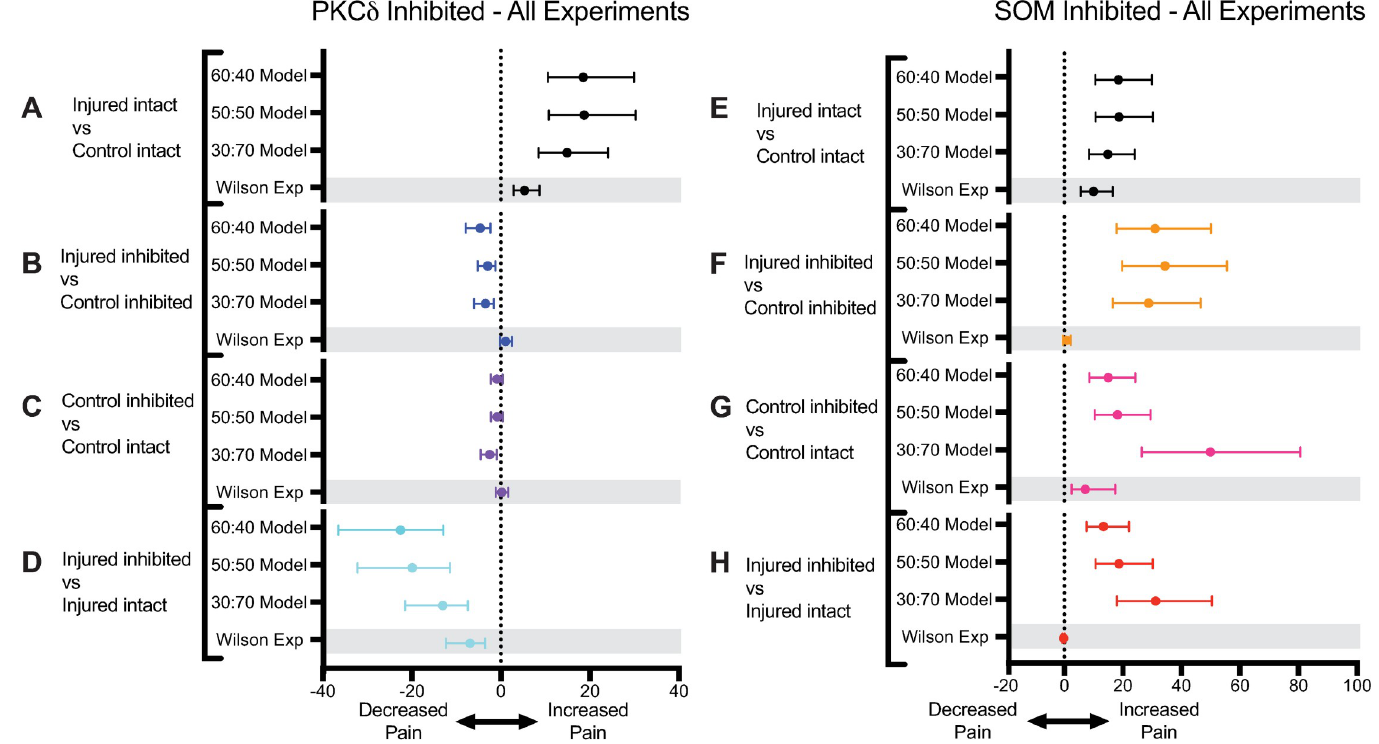
Fig 10. Standardized mean effect differences between wet-lab experiment and model simulations. Hedges’ g standardized mean effect differences were calculated between different groups from our wet-lab experiments and three models (60:40, 50:50, and 30:70) which differed based on the PKC δ :SOM ratio. Forest plots show Hedges’ g +/- 95% confidence intervals. Positive Hedges’ g is indicative of an increase in pain-like effect for the indicated comparison and a negative Hedges’ g is indicative of a decrease in pain-like effects. ( A, E ) Hedges’ g calculations for intact experiment when neither PKC δ nor SOM is manipulated. Black data points show the standardized difference between control groups and injured groups with strong congruency across the wet-lab experiment and all three models showing that injury/damage accumulation leads to an increase in “pain” compared to control condition. ( B-D ) Data showing the impact of PKC δ inhibition. ( B ) Blue data points show the impact of PKC δ inhibition in both the control and injured groups. ( C ) Purple data points show the impact of PKC δ inhibition in the control group only. ( D ) Light blue data points show the impact of PKC δ inhibition in the injured group only. ( F-H ) Data showing the impact of SOM inhibition. ( F ) Orange data points show the impact of SOM inhibition in both the control and injured groups. ( G ) Pink data points show the impact of SOM inhibition in the control group only. ( H ) Red data points show the impact of SOM inhibition in the injured group only. Wet lab data are from published work[16].